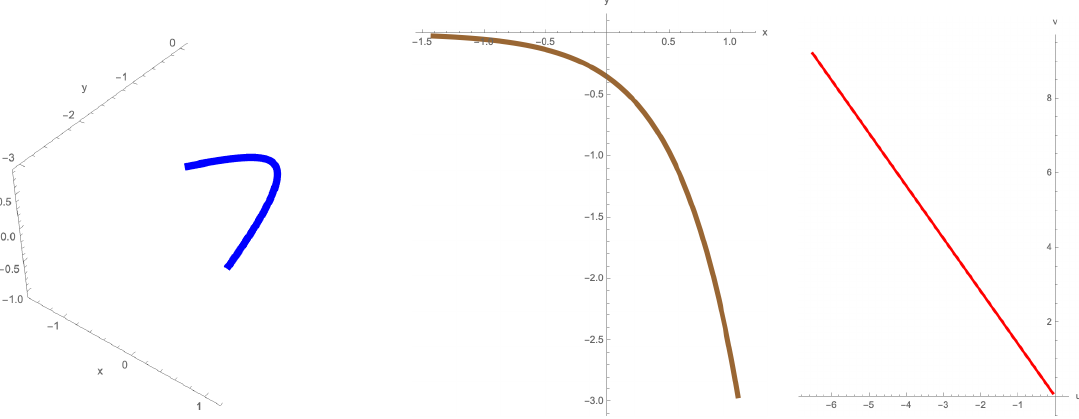
Figure 4. α = 2, ε = 1, q = 1, θ = π